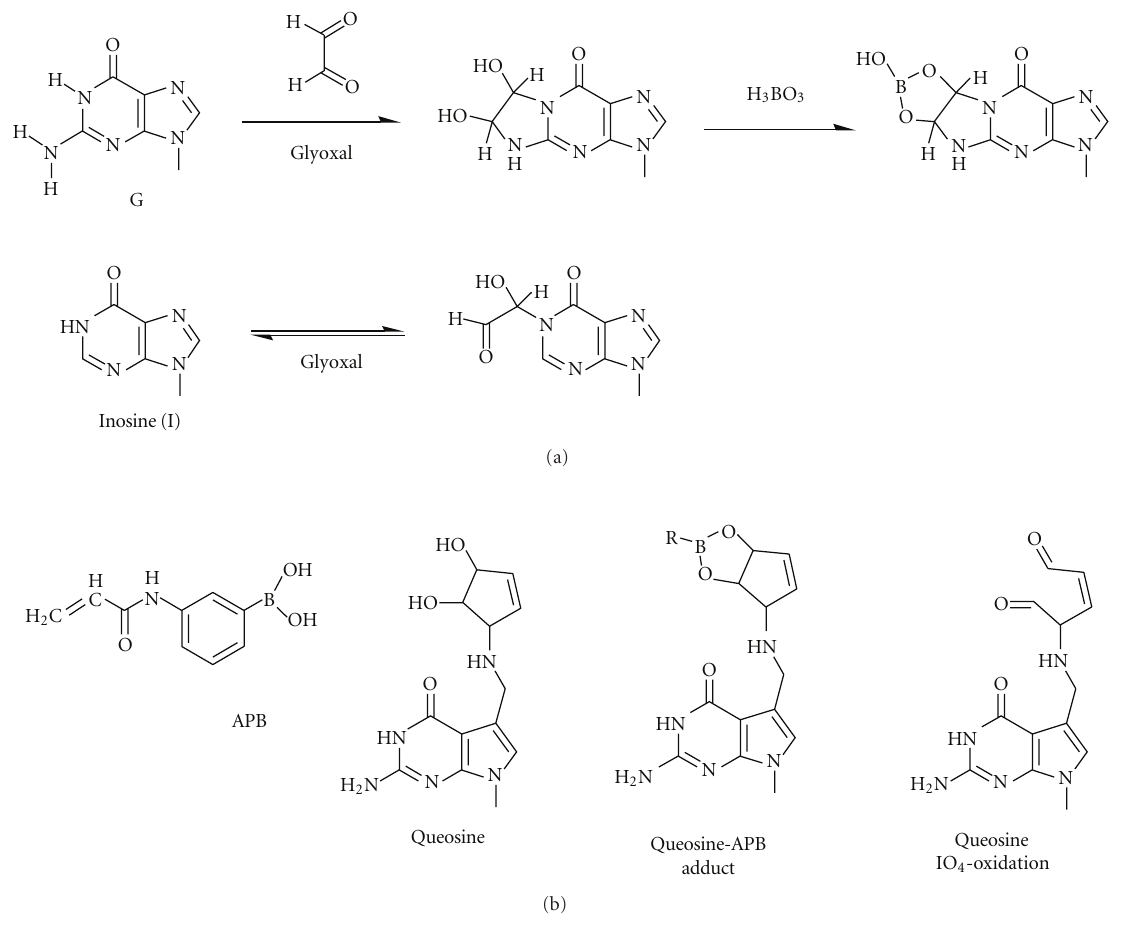
Figure 9: Reaction of guanosine residues in RNA with glyoxal and stabilization of the resulting adduct by boric acid H 3 BO 3 . Inosine residues do not form the stable product under similar conditions (a). Organic derivative of boric acid ( N -acryloylamino)phenyl-3-boronic acid (APB) and its complex with cisdiols present in queosine and the dialdehyde resulting from periodate oxydation of the cisdiol (b).